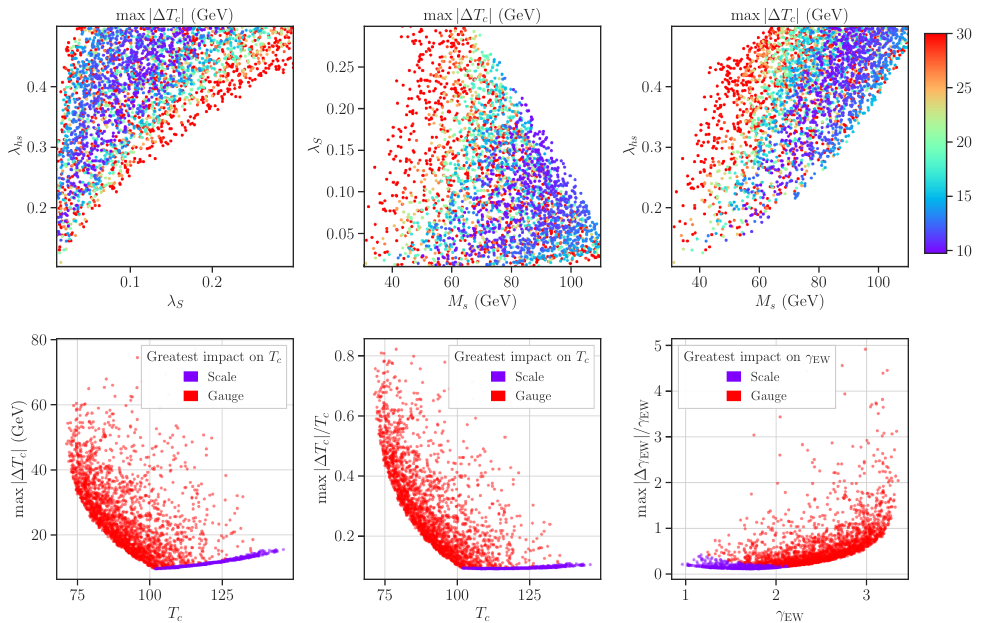
Figure 14 . Results from three-dimensional scans. In the top panels, we show the maximum change in the critical temperature on two-dimensional planes, where points of small uncertainty are on top of points of large uncertainty. In the bottom panels, we show the relationship between the maximum changes in T and γ and their c EW